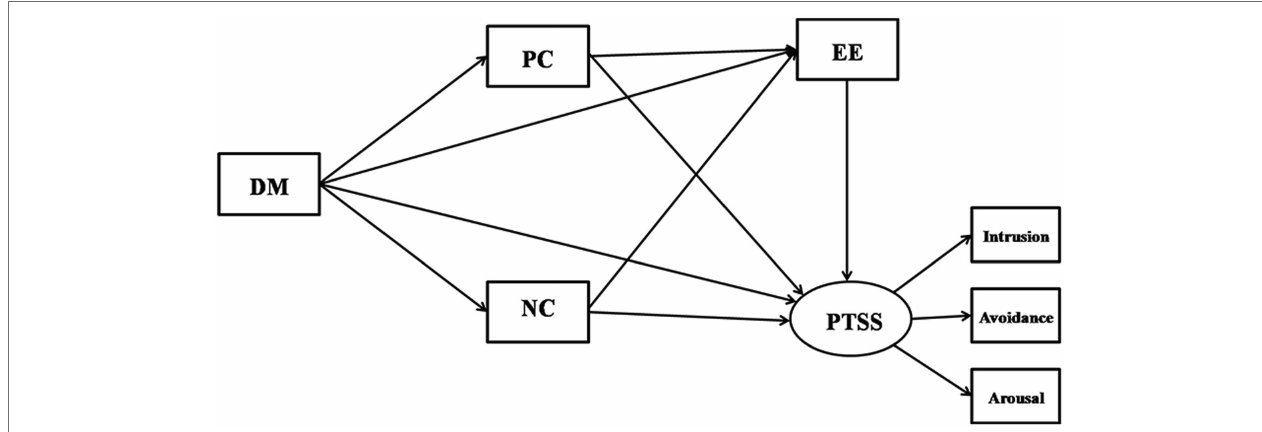
FIGURE 1 | Hypothesized model of direct and indirect relationships between dispositional mindfulness and PTSS. DM, dispositional mindfulness; PC, positive coping; NC, negative coping; EE, emotional exhaustion; and PTSS, post-traumatic stress